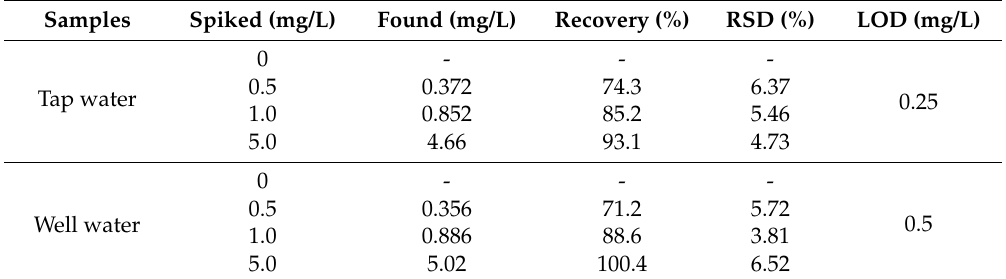
Table 2. Recoveries of metsulfuron-methyl in water samples ( n = 3).